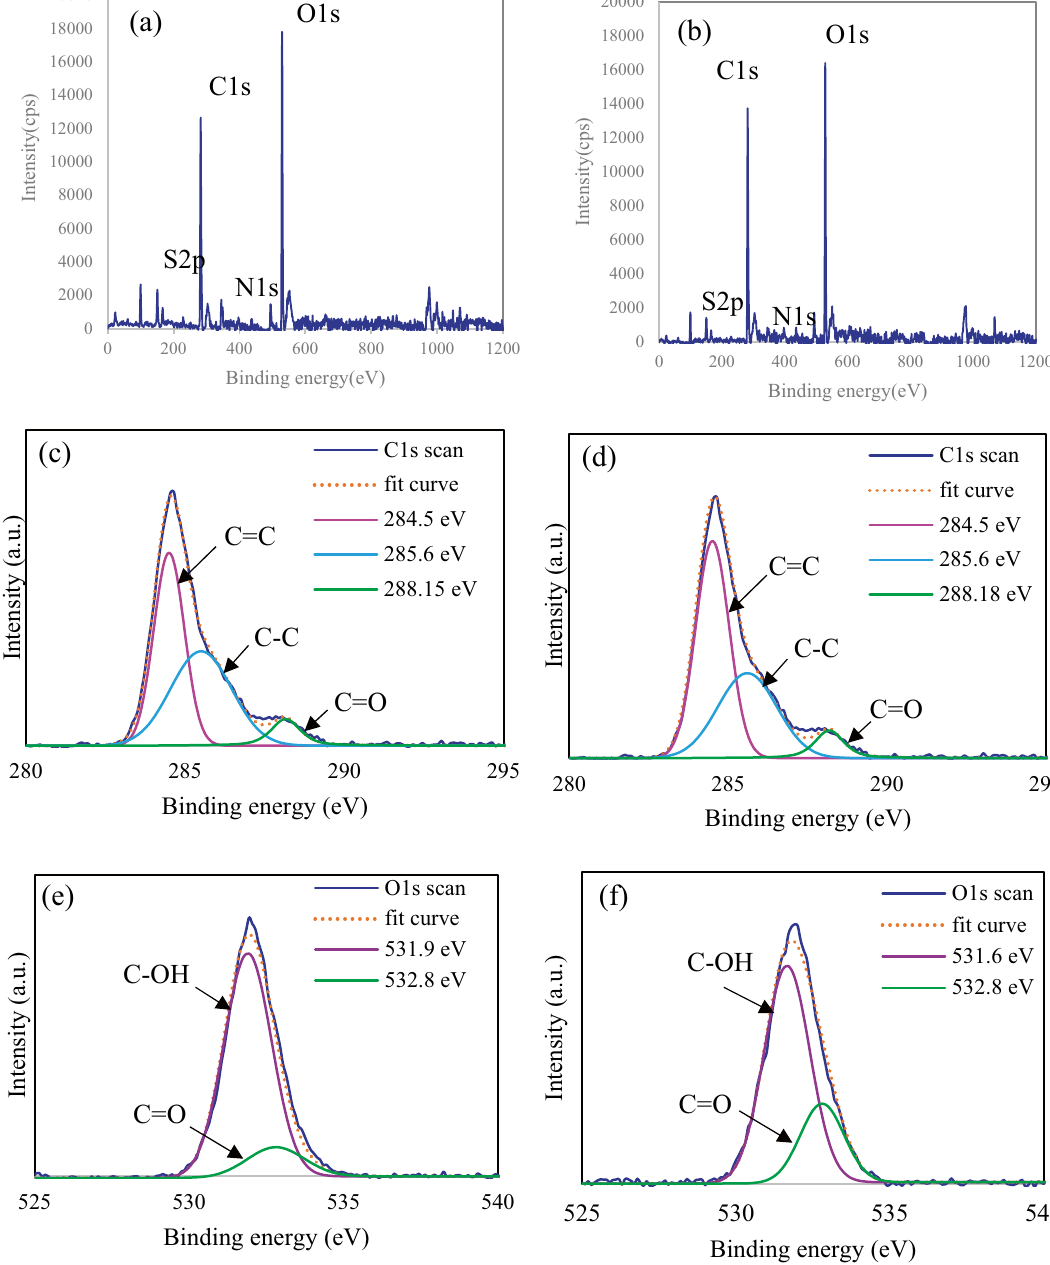
Figure 4. XPS spectroscopic survey of ( a ) CDs-220C-6h, and ( b ) CDs-220C-10h; C1s scan of ( c ) CDs- 220C-6h, and ( d ) CDs-220C-10h; O1s scan of ( e ) CDs-220C-6h, and ( f )